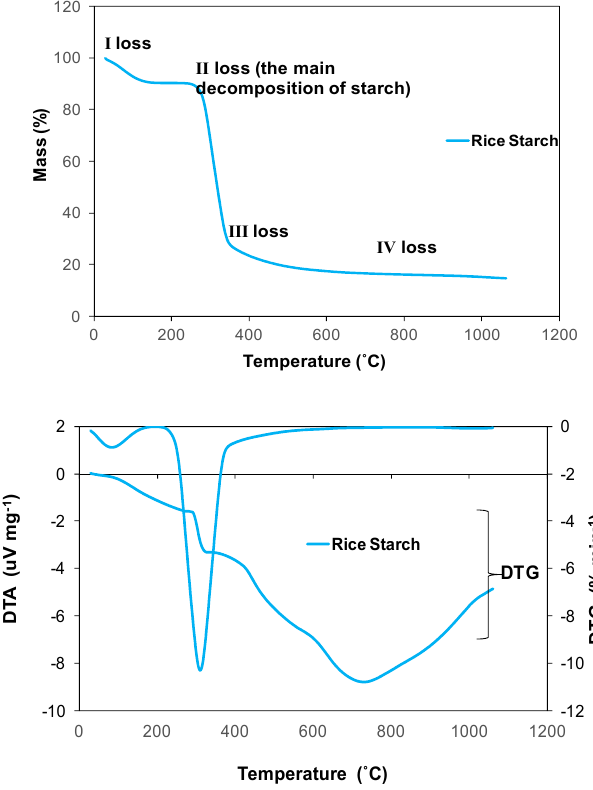
Figure 5. TG/DTG-differential thermal analysis (DTA) of rice starch. Figure 5. TG / DTG-di ff erential thermal analysis (DTA) of rice